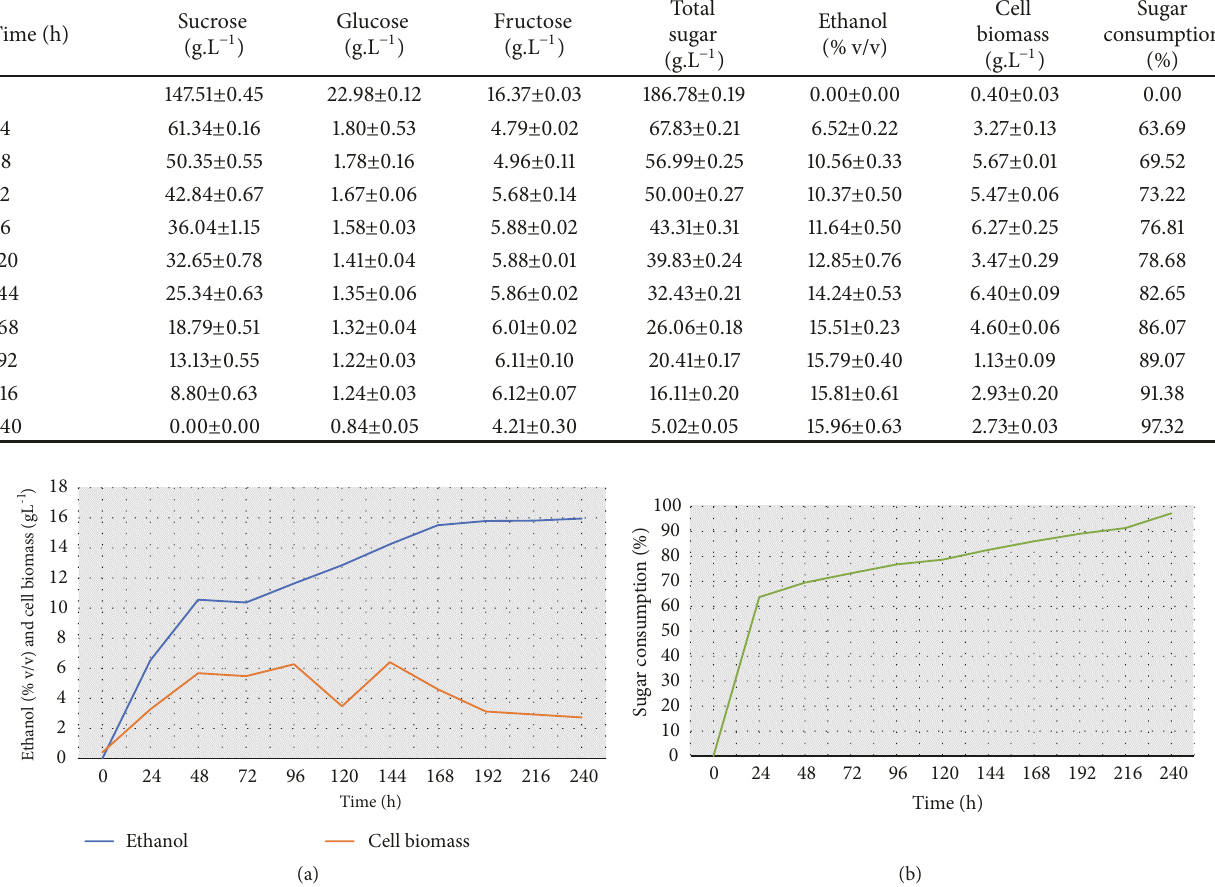
Table 2: Consumption of sucrose, glucose, and fructose and the formation of ethanol during submerged fermentation of cocoa’s residual honey by S. cerevisiae AWRI726 (19 ∘ Brix, 20 ∘ C, and pH 5.0).